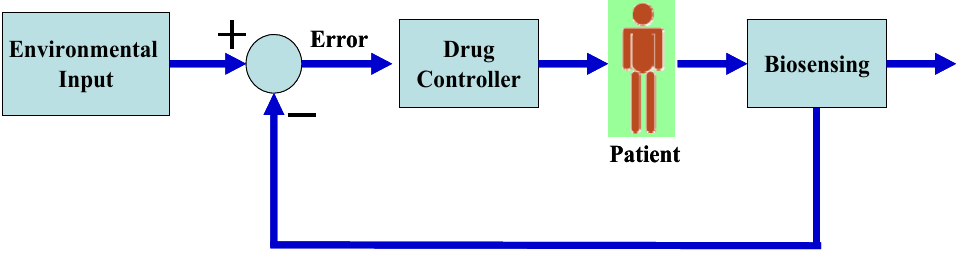
Figure 11. Schematic diagram of feedback controlled personalized medicine.